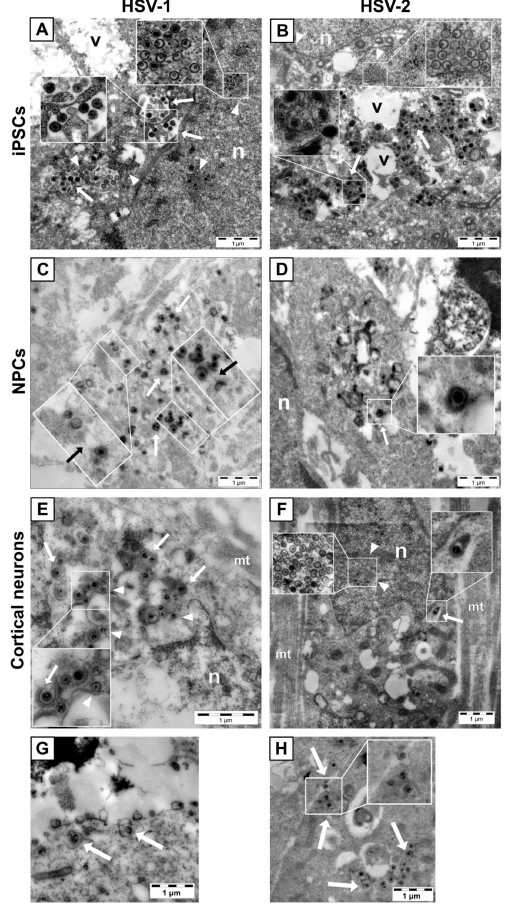
Figure 3. ( A , B ) Envelopment and egress of HSV in iPSCs, NPCs and neurons. Representative images of iPSCs infected with HSV-1 ( A ) or HSV-2 ( B ) at MOI = 3. In iPSCs, capsid envelopment of HSV-1 virions (( A ), white arrows) occurs in large vacuoles in the cytoplasm, while HSV-2 virions (( B ), white arrows) are observed in the cytoplasm outside the vacuoles. Viral capsids in the nucleus and in the cytoplasm are pointed out by arrowheads. ( C , D ) Representative images of NPCs infected with HSV-1 ( C ) or HSV-2 ( D ) at MOI = 3. In NPCs, envelopment of HSV-1 virions (( C ), white arrows) is observed in tubular structures ( C , black arrows in insets) in the cytoplasm. HSV-2 envelopment (( D ), white arrow) is observed in the cytoplasm but not within the tubular structures observed for HSV-1. ( E , F ) Representative images of cortical neurons infected with HSV-1 ( E ) or HSV-2 ( F ) at MOI = 3. Viral capsids are marked with white arrowheads. Egress of both HSV-1 ( G ) and HSV-2 ( H ) particles is observed in tubulo-vesicular structures near the cell plasma membrane of the neuronal soma (white arrows). n, nucleus; v, large, lipid-containing vacuole; mt,